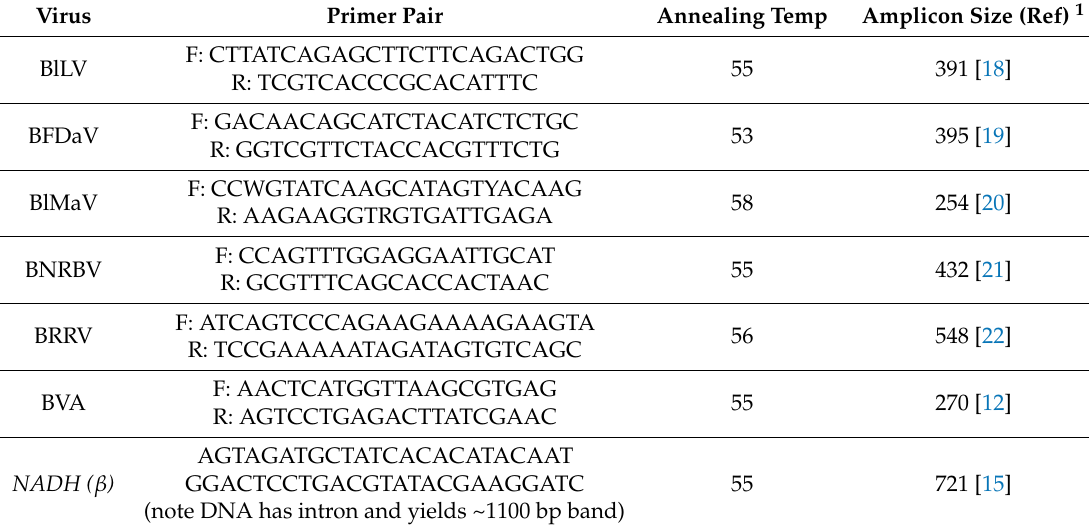
Table 1. Primer pairs, annealing temp, and amplicon size for each of the viruses tested by PCR Virus Primer